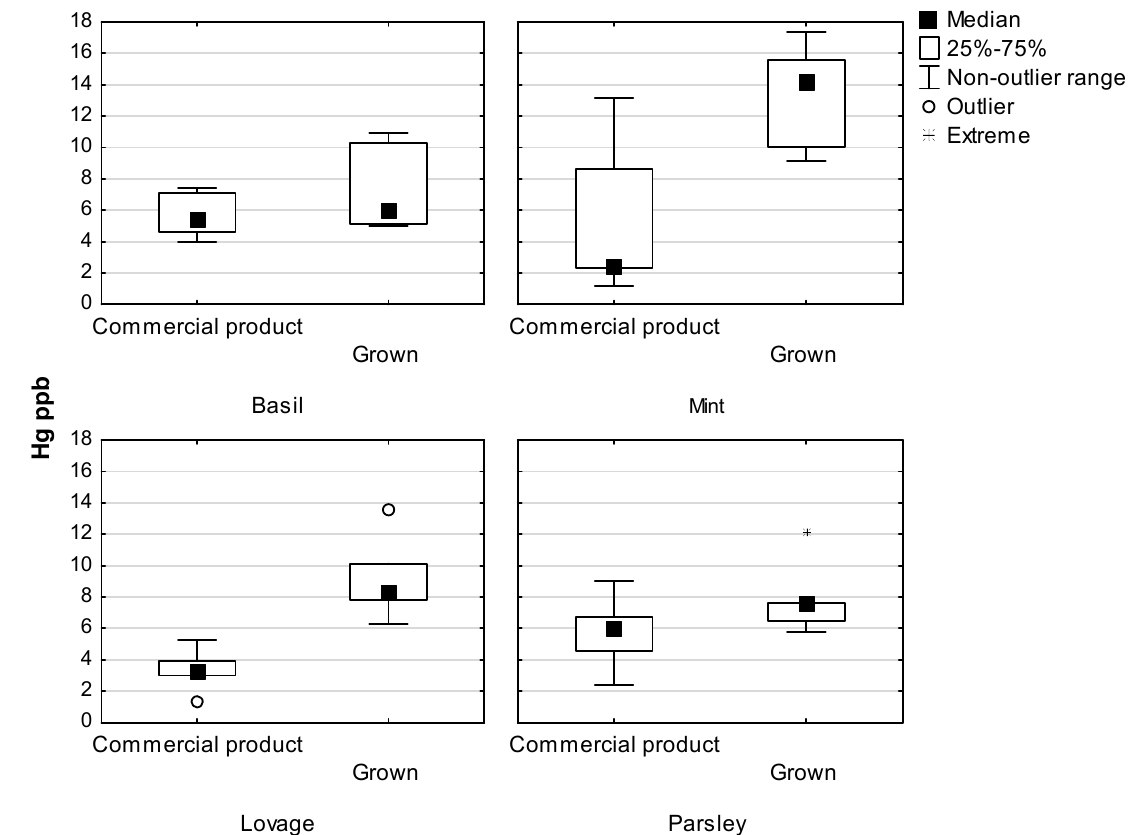
Figure 2. Hg concentration in study spice plants purchased in stores (commercial product) and grown independently, µg/kg.